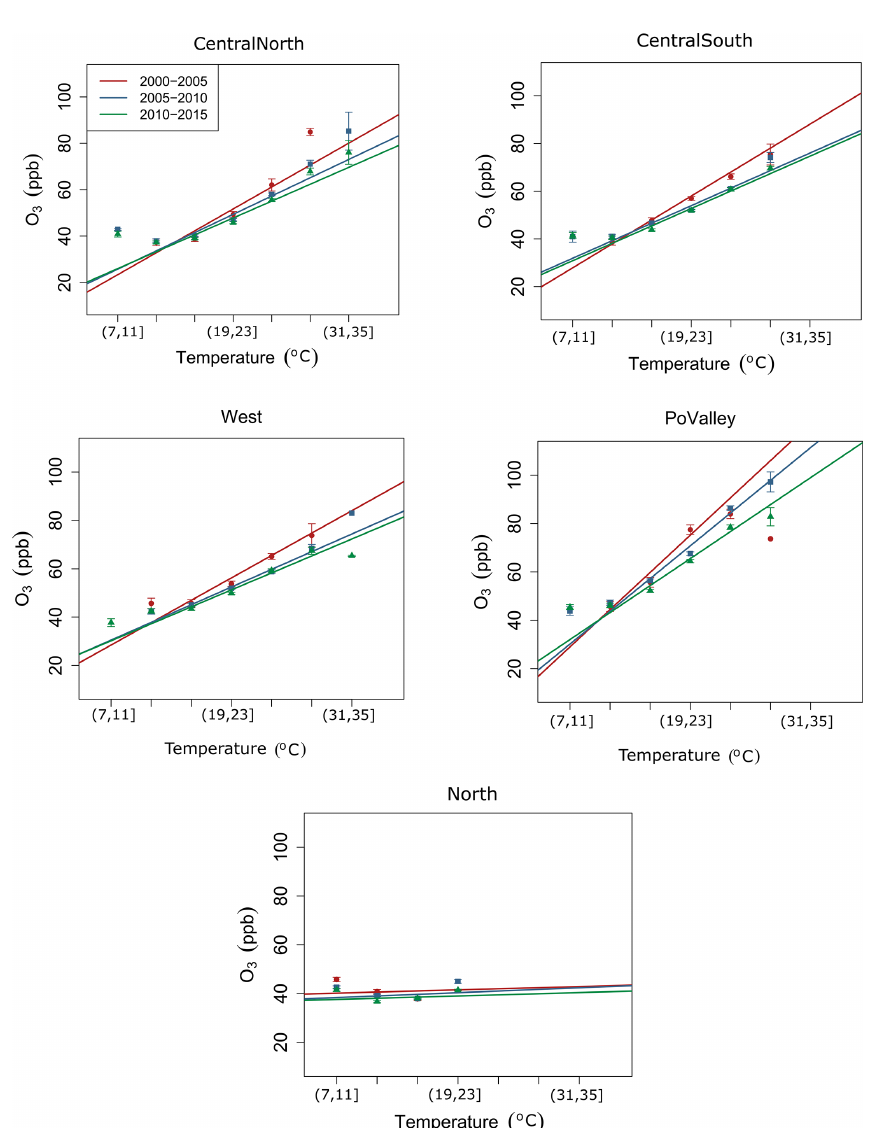
Figure 11. Linear trend of the slope between O 3 –temperature daily maximum values for the warm season between May and September. The trends are calculated on the average values for each daily mean S(t) cluster and for the year groups 2000–2005, 2005–2010 and 2010–2015. Points show the mean value for the indicated temperature bin together with the corresponding standard